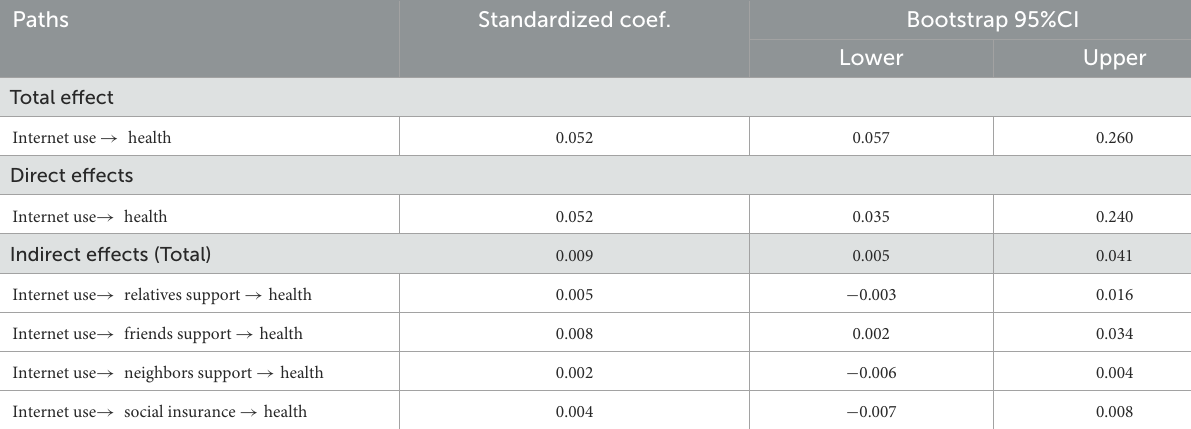
TABLE 8 Mediating effects of social support in urban areas.